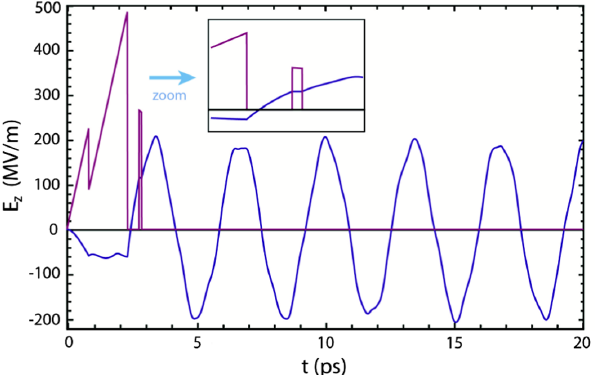
FIG. 1. The wakefield (blue) excited by the optimized current profile (red) with an enhanced transformer ratio. Inset: the wakefield inside of a trapezoidal witness bunch (zoomed in), showing a flat gradient observed by the witness